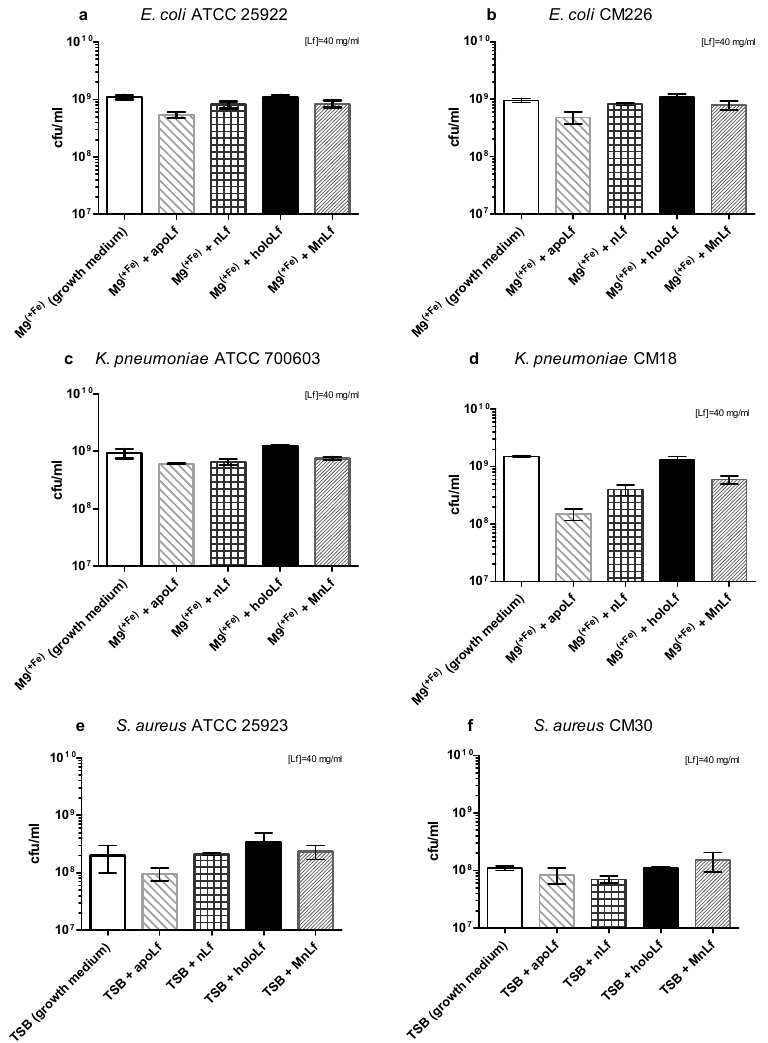
Figure 3. Quantitative assessment of tested pathogenic bacterial strains growth after 24 h incubation with various lactoferrin forms: E. coli ATCC 25922 ( a ), E. coli CM226 ( b ), K. pneumoniae ATCC 700603 ( c ), K. pneumoniae CM18 ( d ), S. aureus ATCC 25923 ( e ), S. aureus CM30 ( f ).